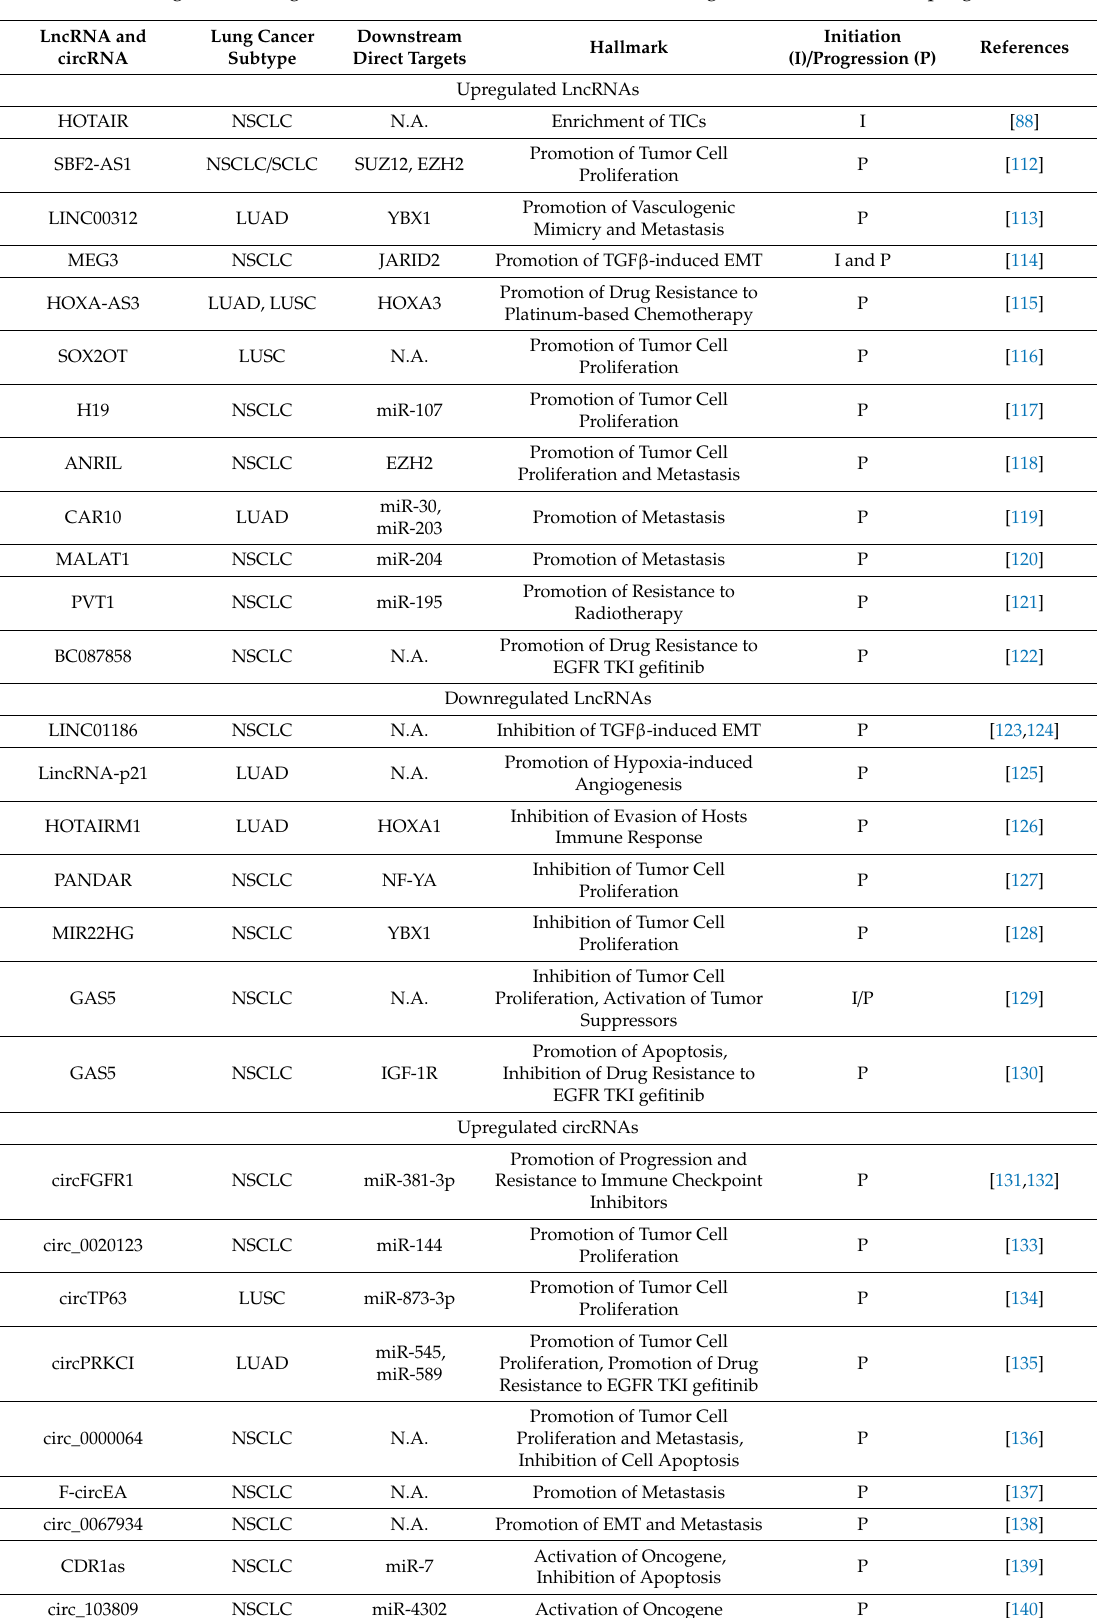
Table 2. Long non-coding RNAs and circular RNAs involved in lung cancer initiation and progression. LncRNA and